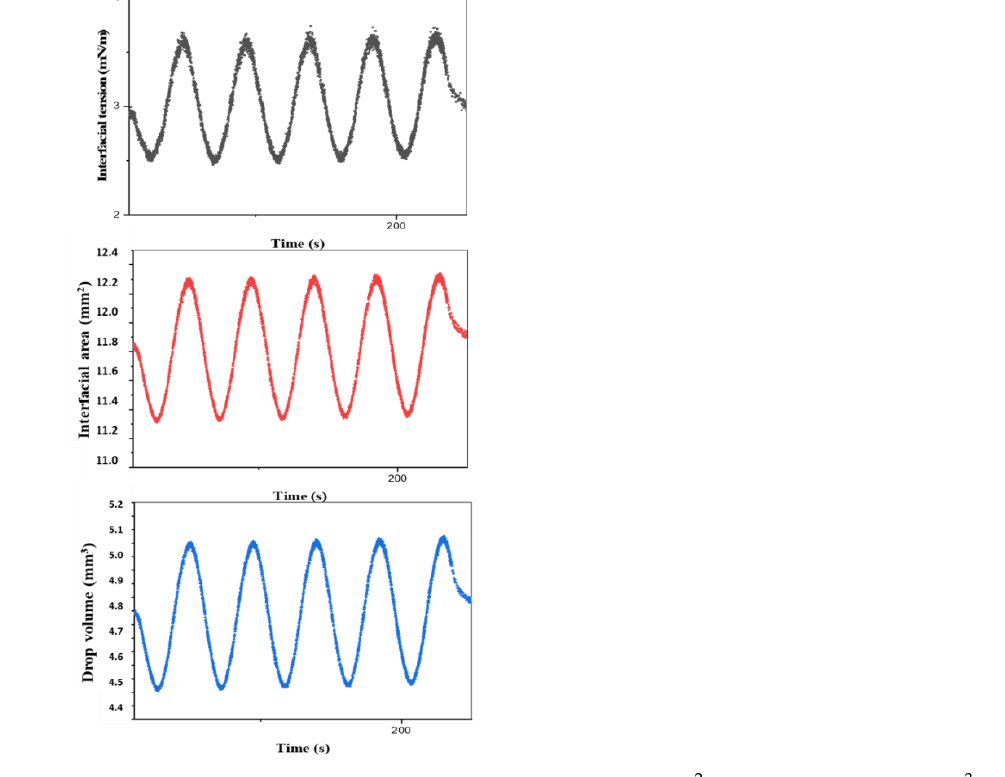
Figure 23. The interfacial tension (mN/m), surface area A (mm 2 ) and drop volume V (mm 3 ) versus time t (s).